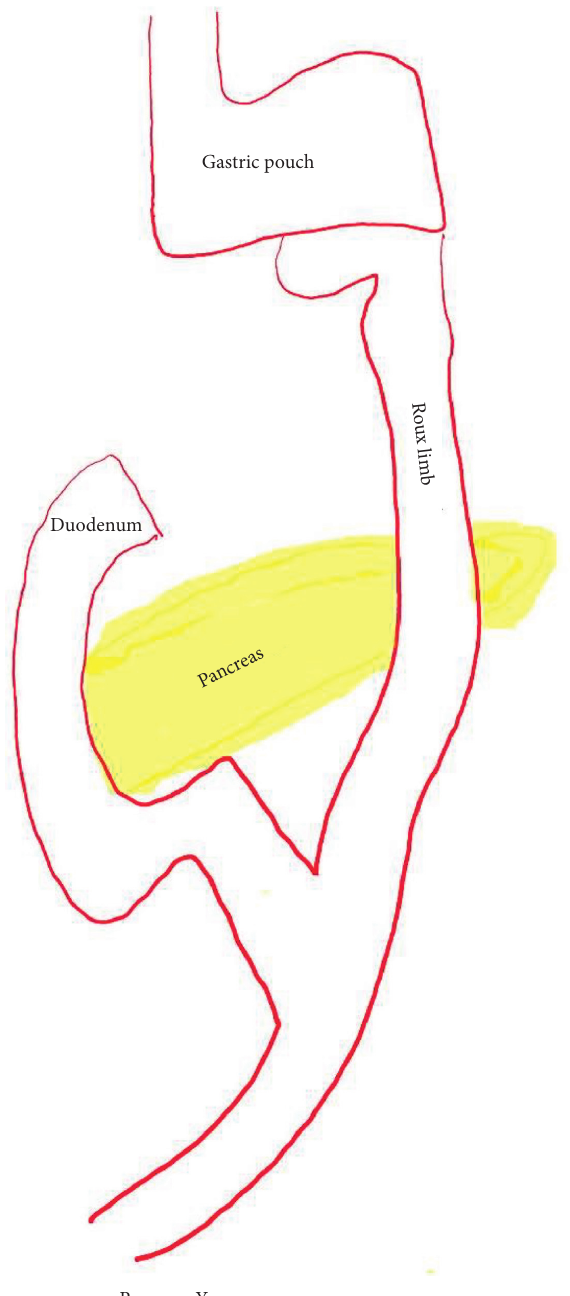
Figure 1: Schematic of surgically altered gastrointestinal anatomy: partial gastrectomy with Roux-en-Y